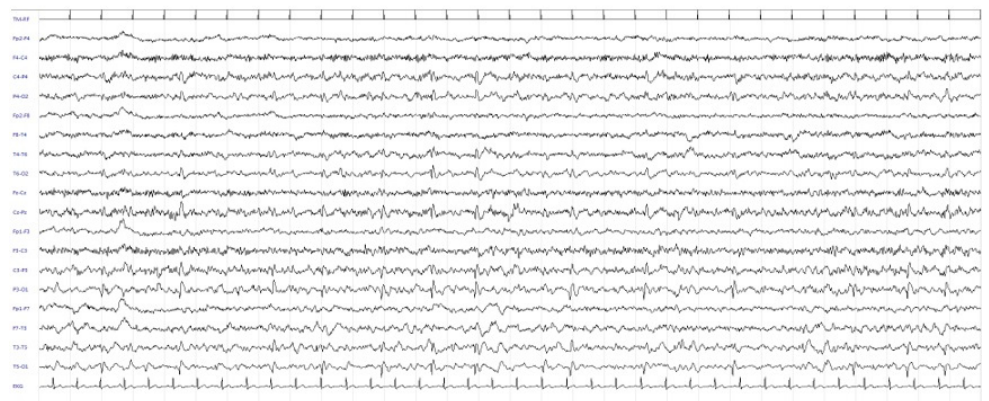
Figure 2. First EEG showing recurrent paroxysmal abnormalities in the right posterior regions with diffusion to the homologous contralateral regions with a periodic trend, which had not been observed in the tracing performed six months before during investigations carried out for RBD .